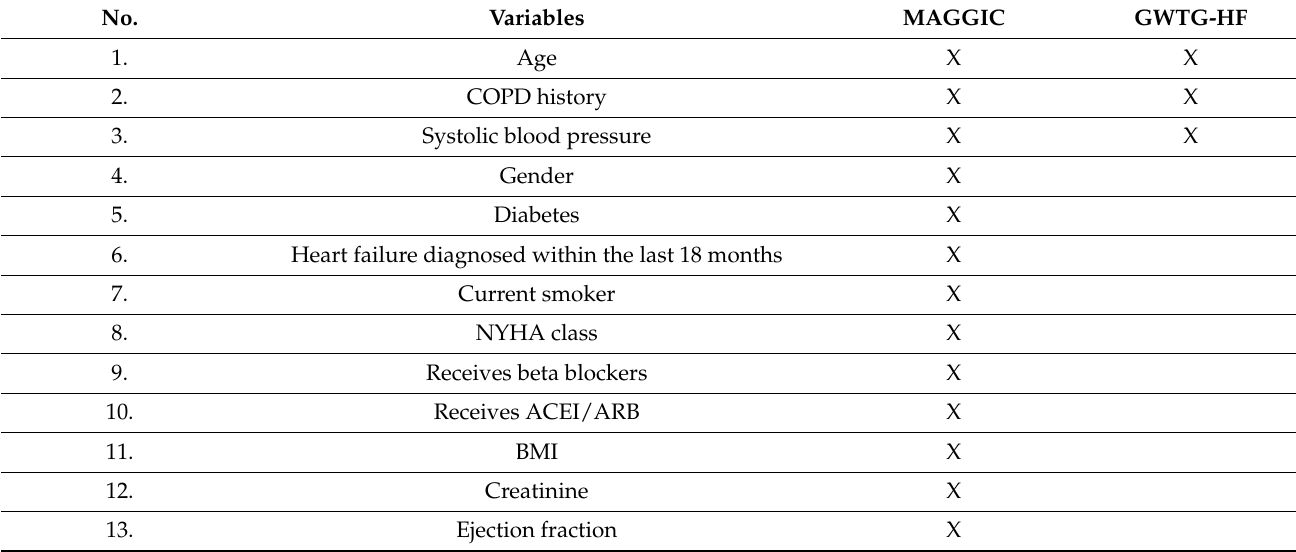
Table 1. Predictor variables used in MAGGIC and GWTG-HF scores. COPD—Chronic